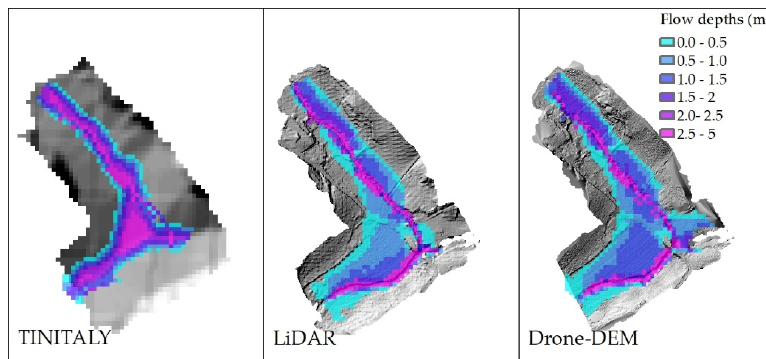
Figure 8. Maximum asynchronous flow depths of the simulations from TINITALY, LiDAR, and Drone-DEM (200 years return period).